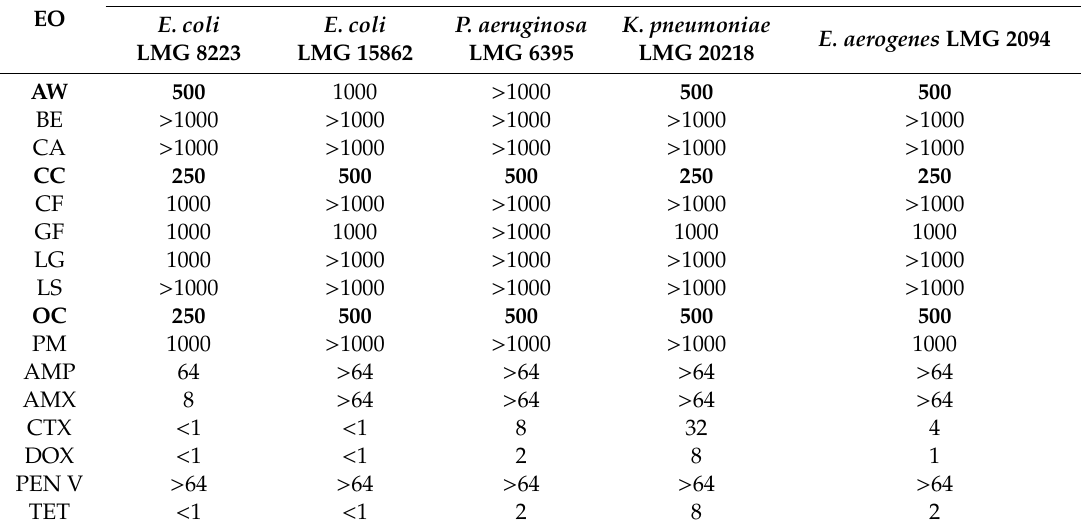
Table 2. Direct activity of the essential oils against the Gram-negative strains ( n = 6). In bold, the most promising